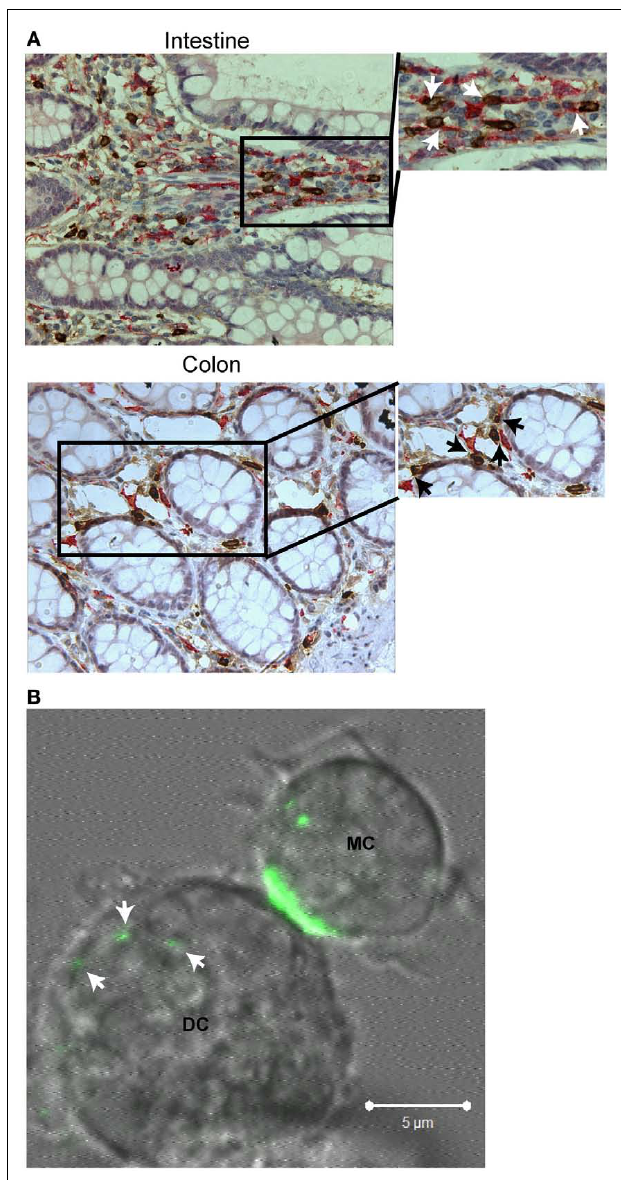
FIGURE 2 | Interactions between mast cells and dendritic cells . (A) Immunohistochemistry of normal human intestinal and colon tissue double stained for mast cell tryptase (brown) and CD209 (DC-SIGN, pink). Arrows within blown up sections indicate regions where direct contact between the two cell types is observed. (B) Live cell, confocal imaging of a mouse bone marrow-derived mast cell primed with α -DNP IgE A488 (green) directly interacting with a mouse bone marrow-derived dendritic cell after activation with DNP–BSA. Arrows indicate where mast cell internalized material has been transferred to the dendritic cell. All images have been brightness and contrast